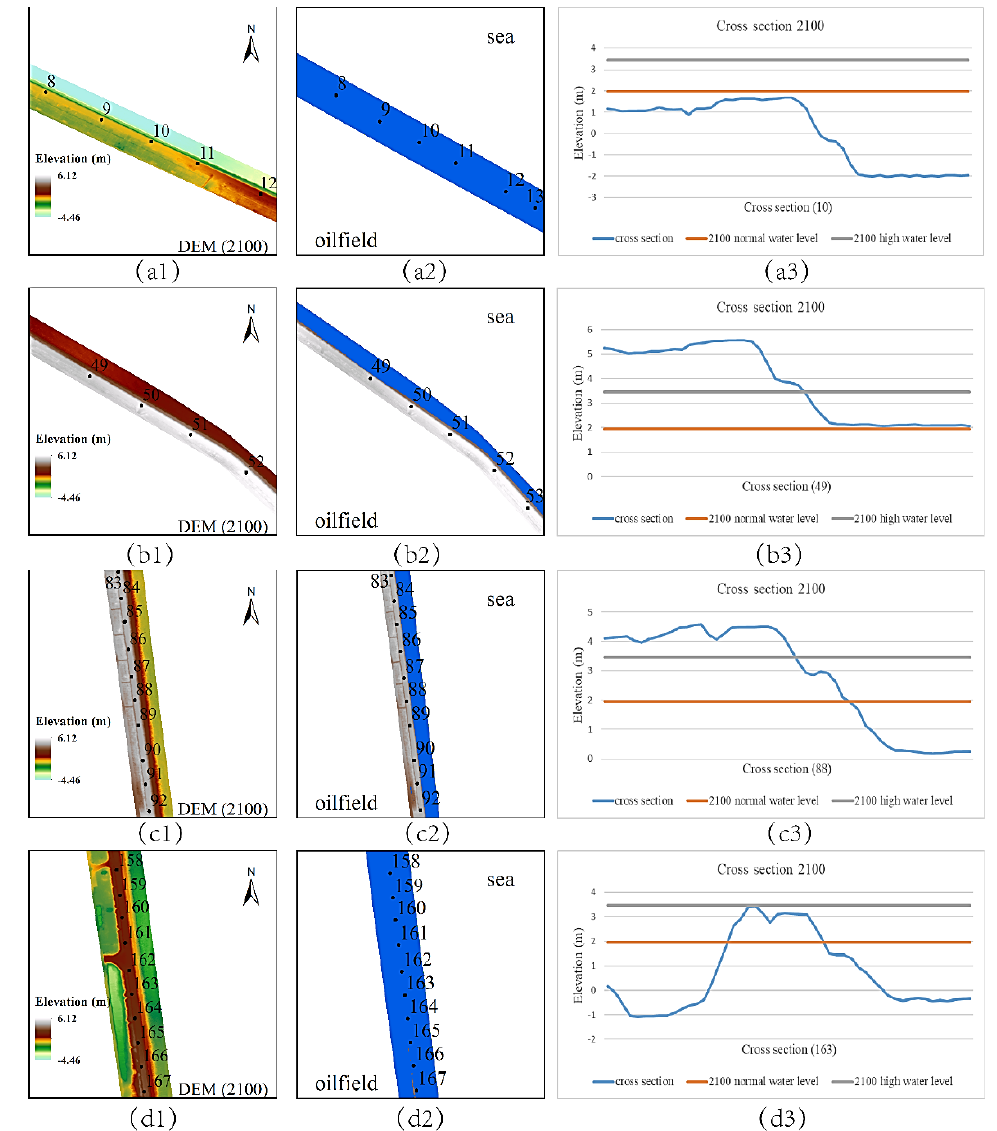
Figure 31. Cross section of the dam and 2D inundation diagram for 2100. The first column shows the DEM of four different parts of the dam in 2100, and the second column indicates the inundation range of the dam due to the high sea-level (3.46 m), shaded in blue. The third column represents a cross section of the dam at points 10, 49, 88 and 163, in which the right direction is seaward. The dam at points 10 and 163 will lose its protective capacity completely, and seawater will easily overflow the dam crest.